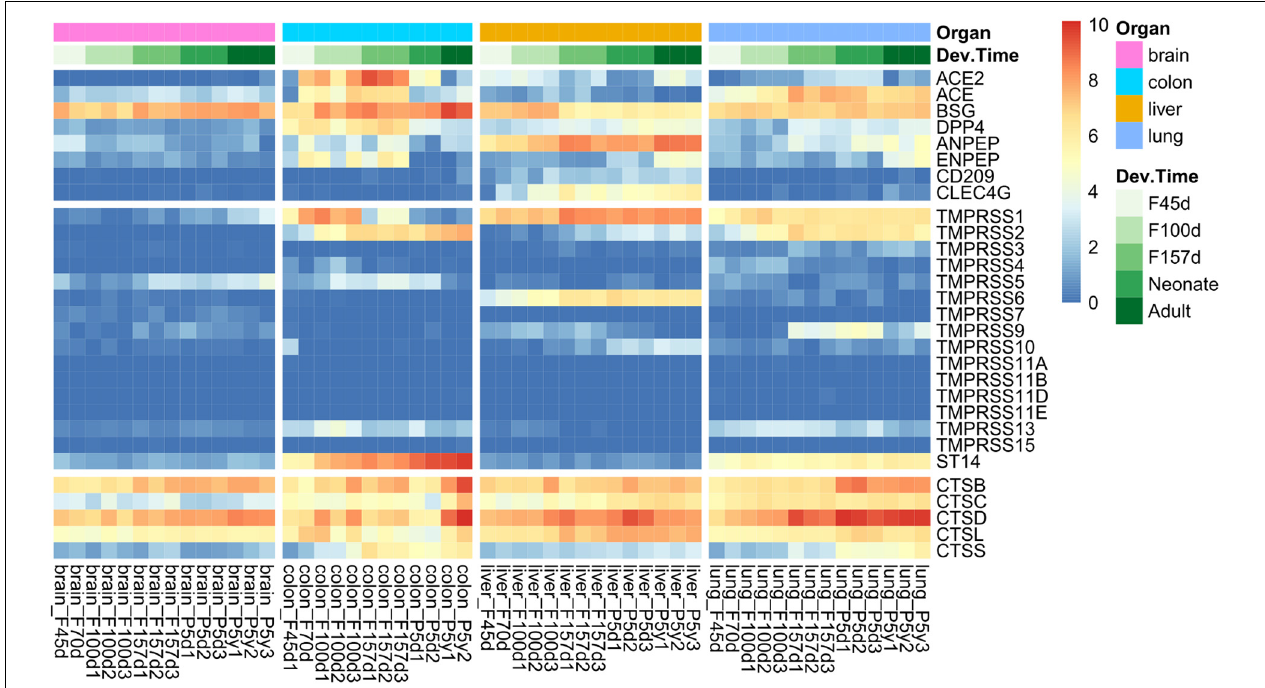
FIGURE 1 | Spatiotemporal expression of severe acute respiratory syndrome coronavirus 2 (SARS-CoV-2) infection mediators in Rhesus monkey development. The heatmap represents gene expression value [log2(RPKM + 1)] of tissues from four organs at different developmental stages, including early (F45d–F70d), middle (F100d), and antenatal (F157d) stages of fetuses, neonates (post born 5–7 days), and adults (post born 5–7 years).